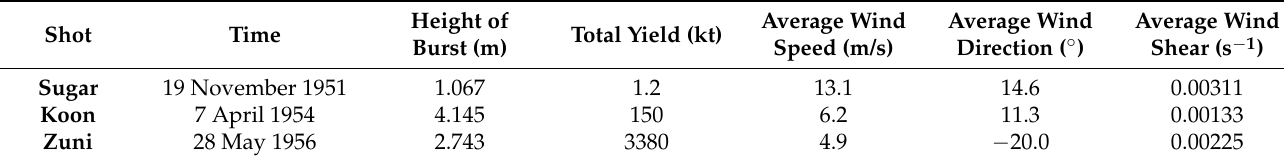
Table 2. Information on historical nuclear test data [54,55].